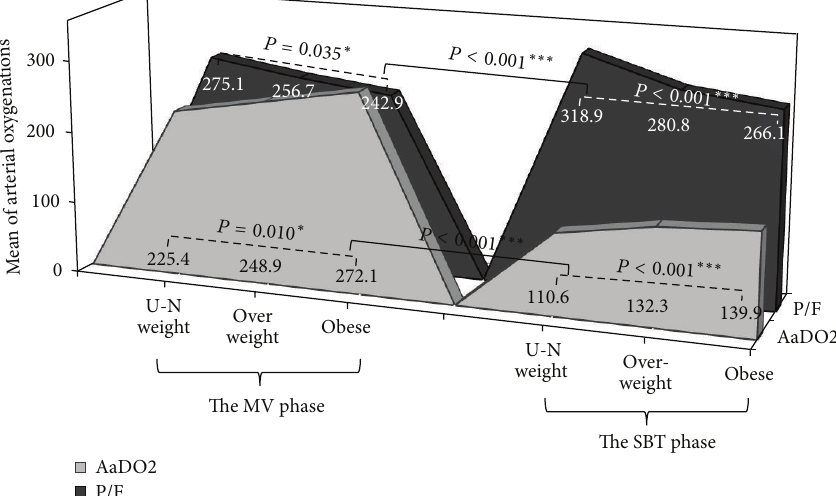
Figure 1: Distribution of the arterial oxygenation levels in the MV and the SBT phases of the BMI groups (see Table 2).